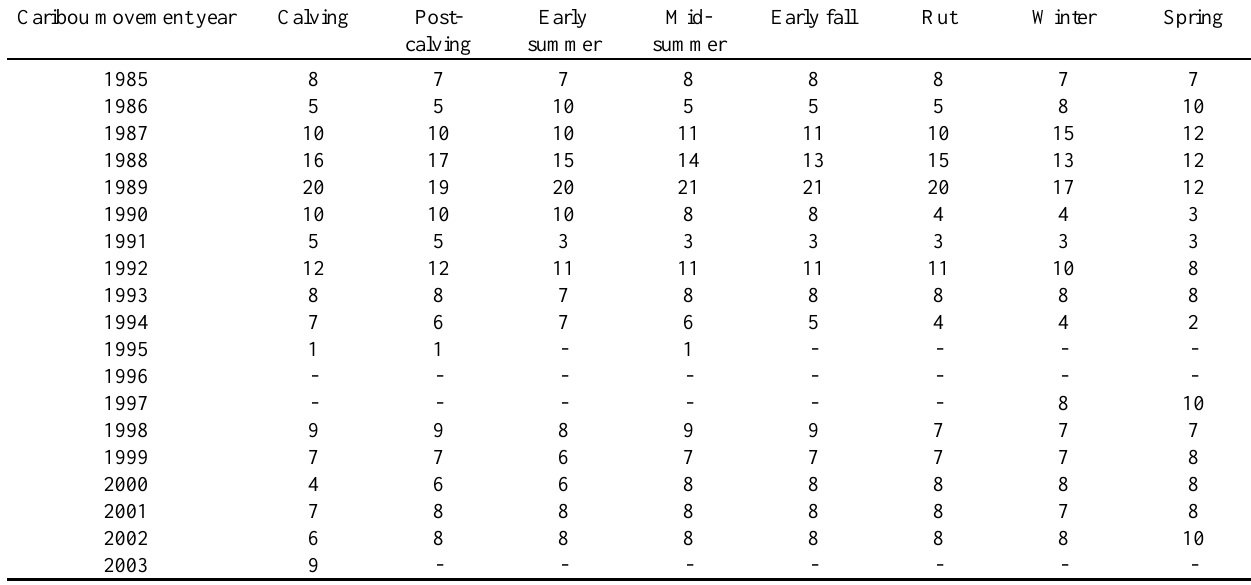
Table 1 . Number of collared animals by season. The eight seasons of a model year run from calving in the calendar year through spring of the following calendar year, i.e., calving in model year 1985 represents June 1985, while spring migration represents April/May 1986. Caribou movement